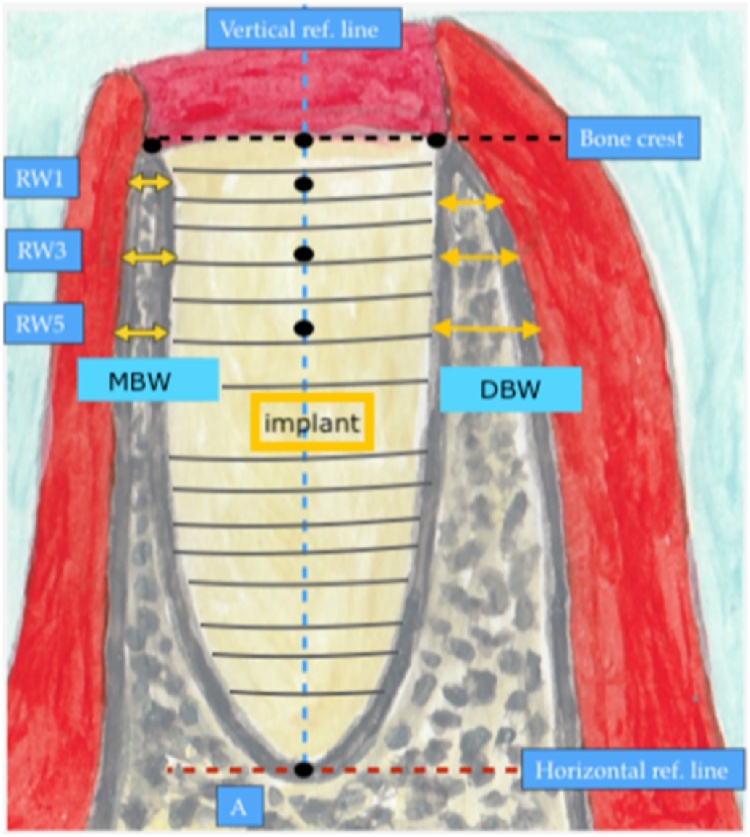
The illustration shows how the bone height and width were measured immediately (D0) and 1 year (D1) after implant insertion. Two reference lines are drawn: the blue, vertical, broken line denotes the center of the implant crossing the apical reference point, while the red, horizontal, broken line. Present the apical limit for measuring the crestal bone height. The mesial bone width (MBW) and distal bone width (DBW) are also shown.